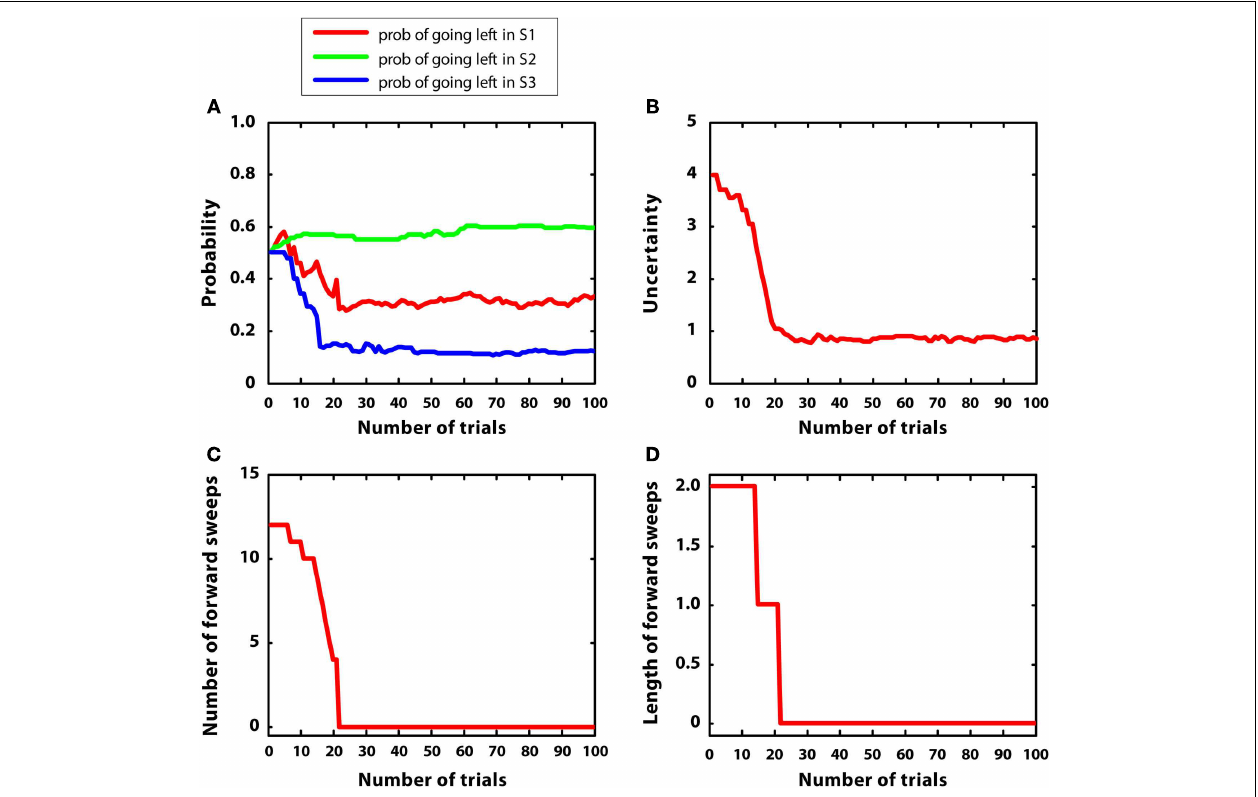
FIGURE 6 | Results of simulation 2, complex and stable environment with low variance. (A–D) : see Figure 5 .